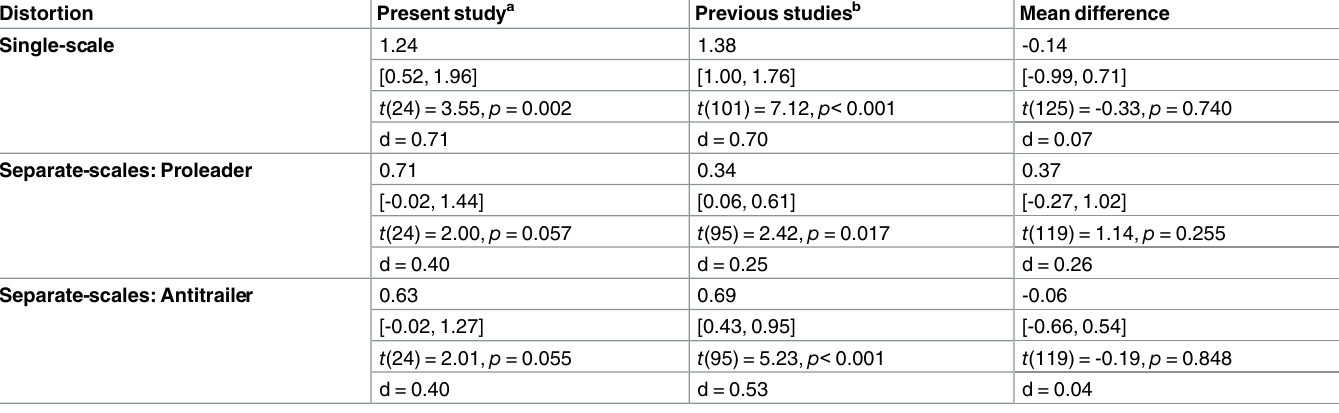
Table 2. Meandistortionin the presentstudy vs. previousstudies (Kostopoulou et al., [15]and Nureket al. [21],study 1). Distortion Presentstudy a Previous studies